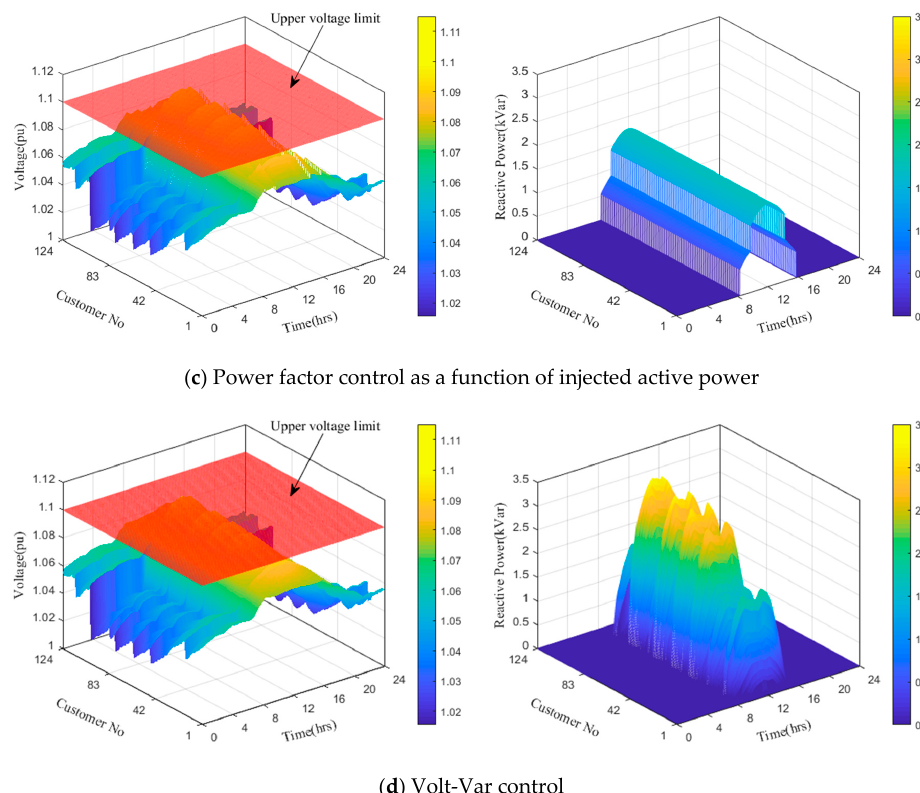
Figure 10. Daily variations of the voltage of all customer nodes and the reactive power compensation of different reactive power control techniques. Similarly, the daily variations of the terminal voltage and active and reactive power output of the PV inverter connected to the critical node for all of the control techniques are shown in Figure 11.